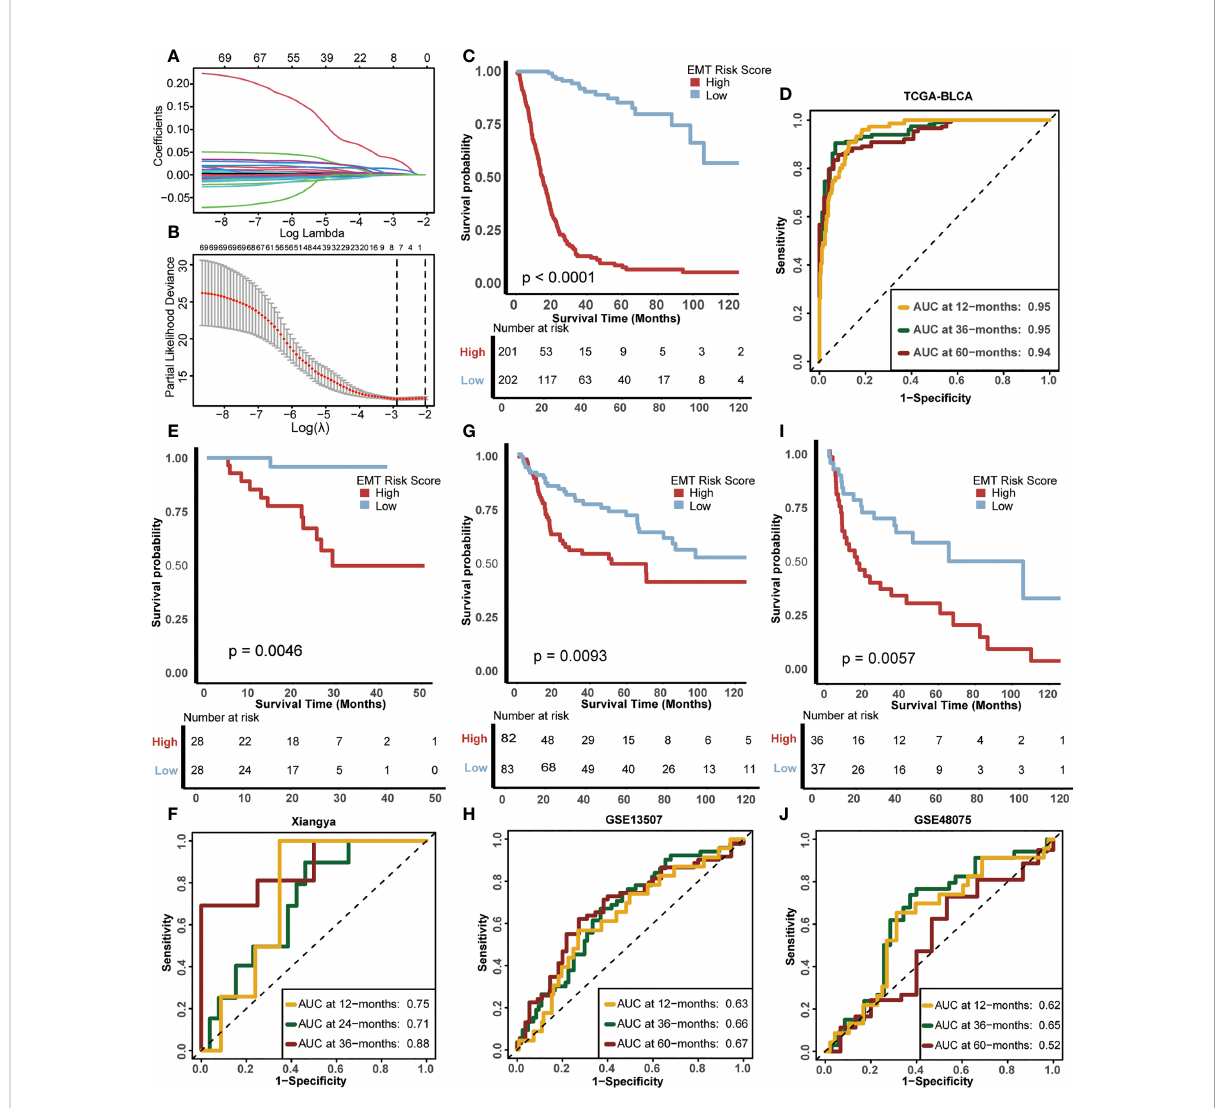
FIGURE 3 Construction of EMT risk score and survival veri fi cation of internal and external cohorts. (A) Coef fi cients of EMT-related differential expressed genes (DEGs) with prognostic value are shown by lambda parameter. (B) Partial likelihood deviance versus log (lambda) drawn by LASSO algorithm and 10-fold cross-validation. (C) Kaplan-Meier (K-M) plot of OS between EMT risk score groups; Red and light blue lines represented high and low EMT risk score groups, separately. (D) The area under curves (AUCs) plot of EMT risk score in TCGA-BLCA cohort. (E, F) K-M plot of OS between EMT risk score groups and AUCs plot of the risk score the in Xiangya validation cohort, separately. (G, H) K-M plot of OS between EMT risk score groups and AUCs plot of the risk score in the GSE13507 validation cohort, separately. (I, J) K-M plot of OS between EMT risk score groups and AUCs plot of the risk score in GSE48075 validation cohort, separately. Red and light blue lines represented high and low EMT risk score groups,